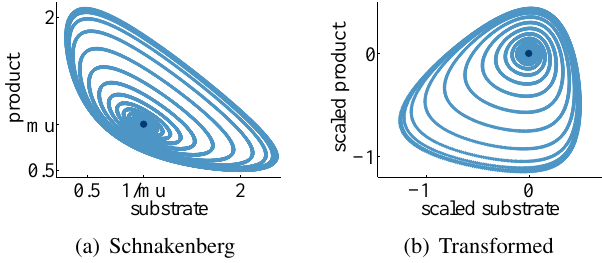
Figure 2. Phase space for the limit-cycle reaction (3), given by numerical solution. The phase curve spirals out from the steady state to meet the limit cycle (broad loop). The Schnakenberg (a) system is highly elliptical, even at the start of the trajectory, by the steady state. The transformed Schnakenberg (b) shows a more circular behaviour initially, but the limit cycle shape remains more complicated. The parameter here is µ = 0 . 95 . The solution was found using Matlab